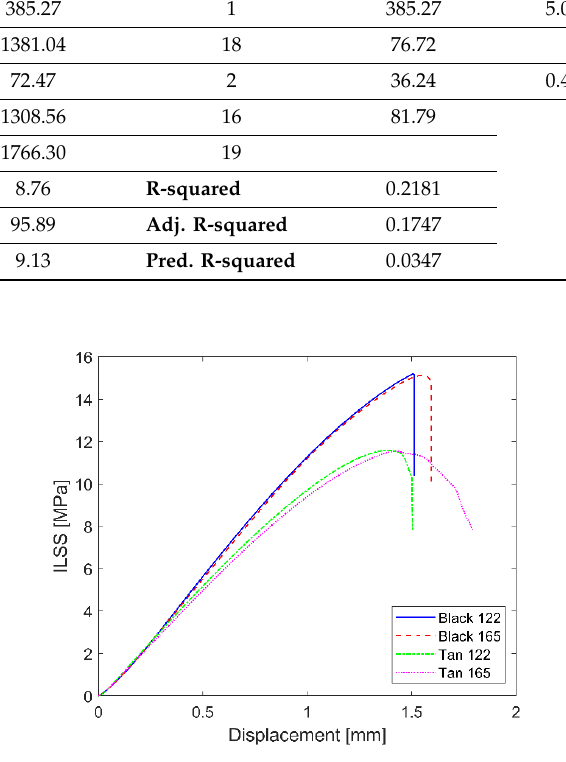
Figure 11. Average ILSS versus displacement curves. Table 6. ANOVA table for ILSS test (response: short-beam strength).